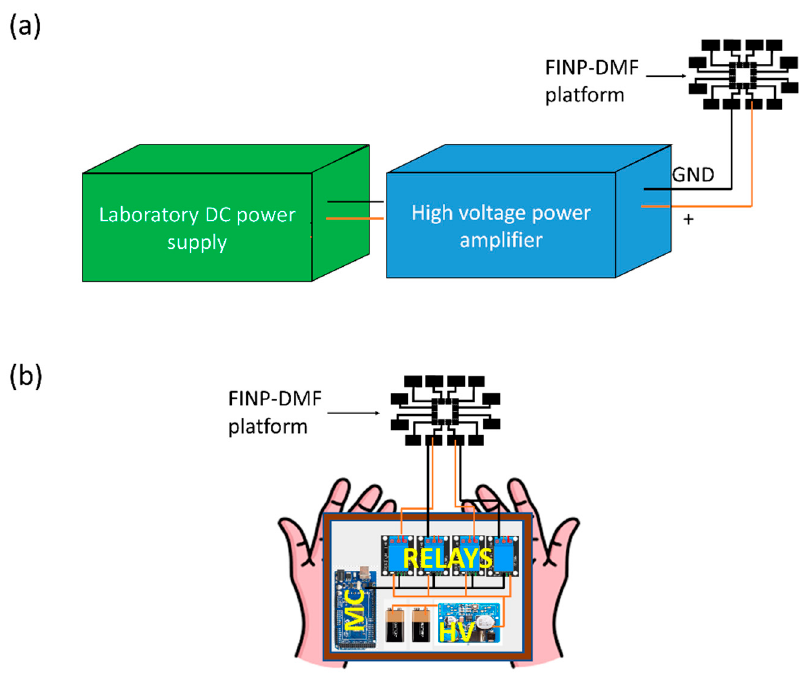
Figure 6. ( a ) Schematic of a bulky control circuitry, a laboratory DC power supply along with a high voltage amplifier. ( b ) Schematic of the portable control circuitry. Two 9 V batteries in series are used with the miniaturized high voltage, step-up DC–DC converter (HV), along with the microcontroller (MC), and relay circuitry to create a lightweight and compact version of control circuitry for switching electrodes on and off.